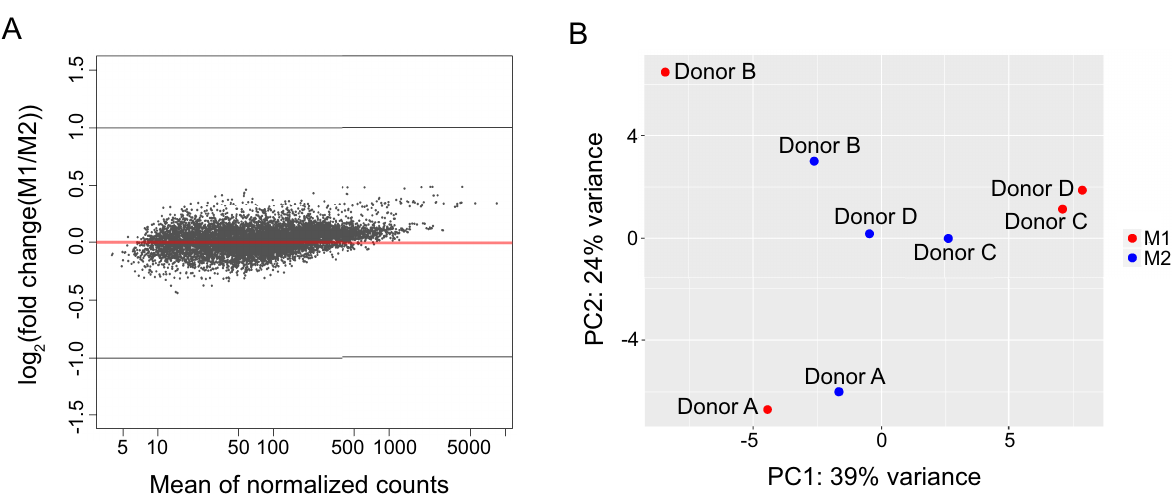
Fig 3. DNA methylation is not a major regulatory mechanism of macrophage polarization. (A) MA plot (B) PCA plot of the promoter DNA methylation sites identified by methSeek in M1 and M2 macrophages. Red and blue data points represent M1 and M2 macrophages, respectively.